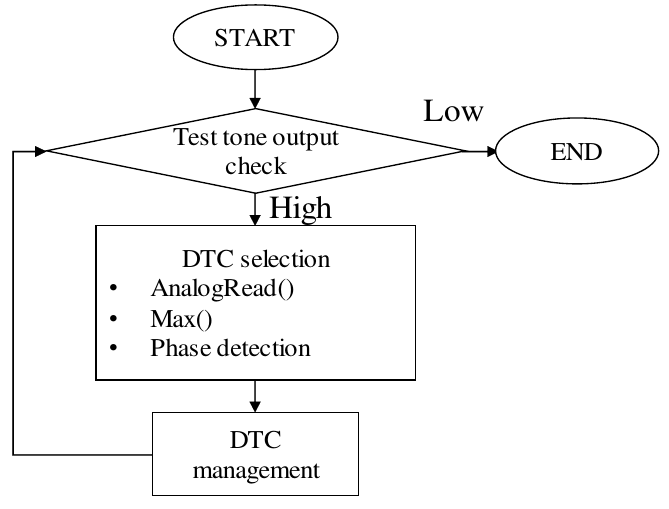
Figure 12. Flow chart of the imbalance detection and DTC management